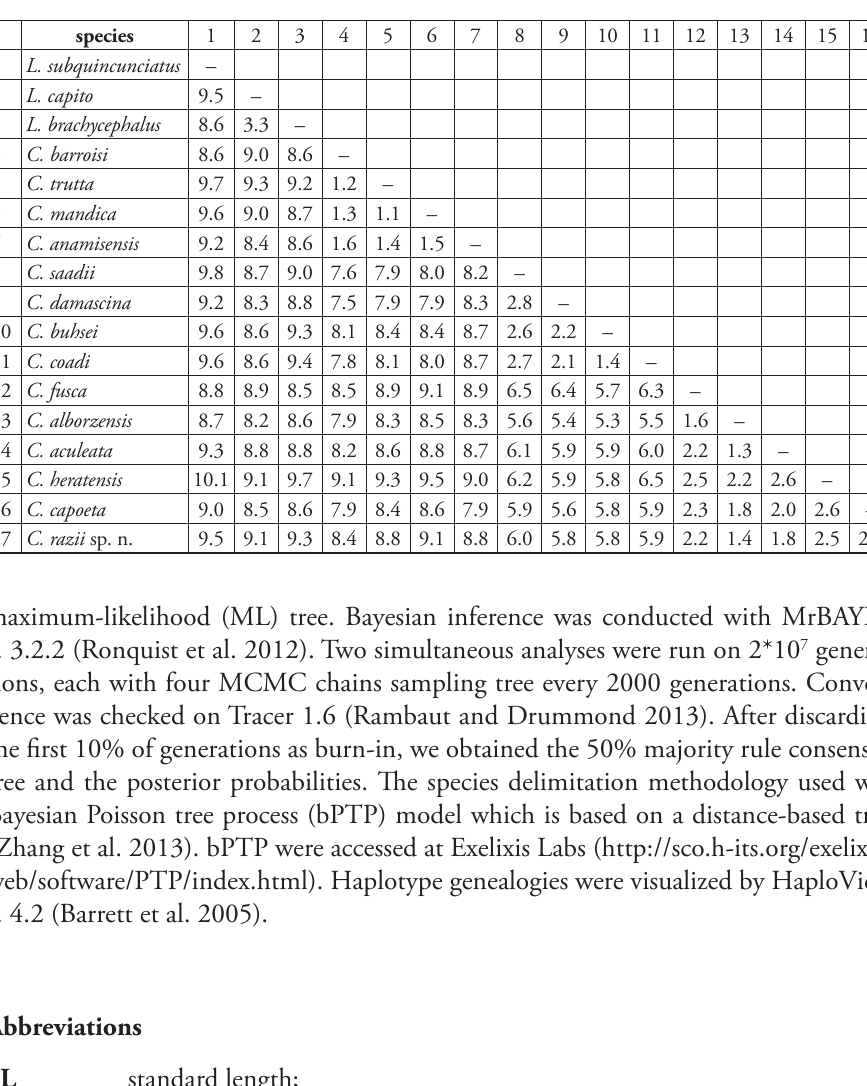
Table 3. Estimates of evolutionary divergence over sequence pairs between Capoeta razii sp. n. and other Iranian Capoeta